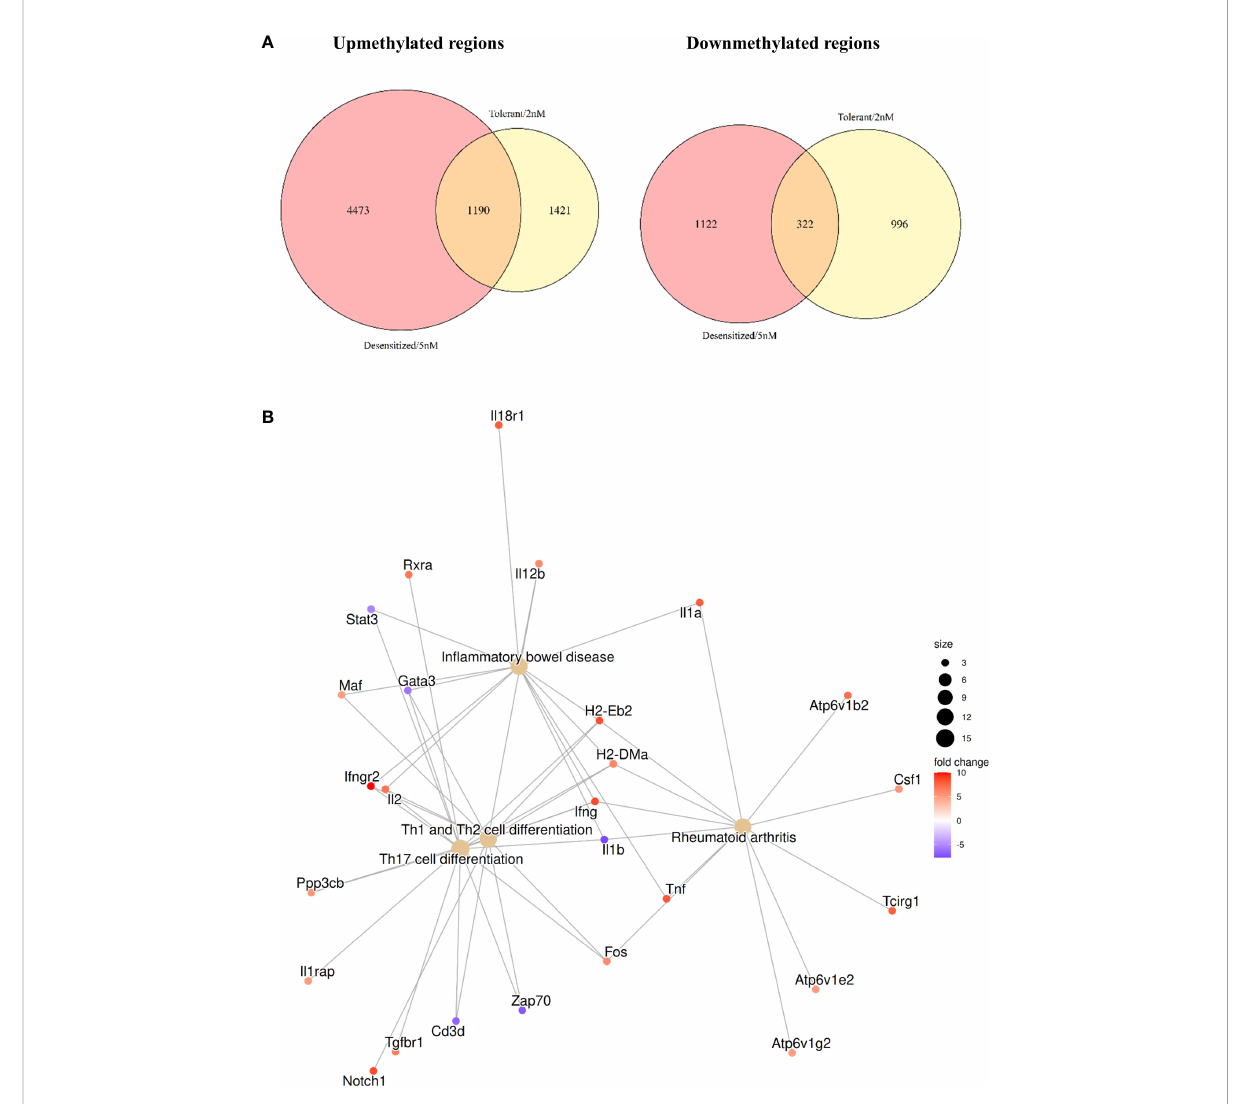
FIGURE 4 Comparison of the DMPRs found for each D1ManPrup3-SLIT group. (A) Venn diagrams contrasting upmethylated and downmethylated regions, respectively. (B) Highlighted enriched KEGG terms obtained with common D1ManPrup3-SLIT